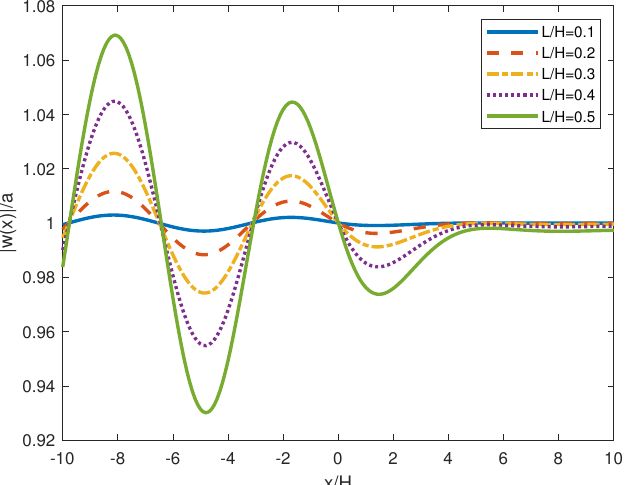
Figure 5. The dimensionless amplitudes of ice deflection for ω = 0.5 s − 1 and different rigid plate length.